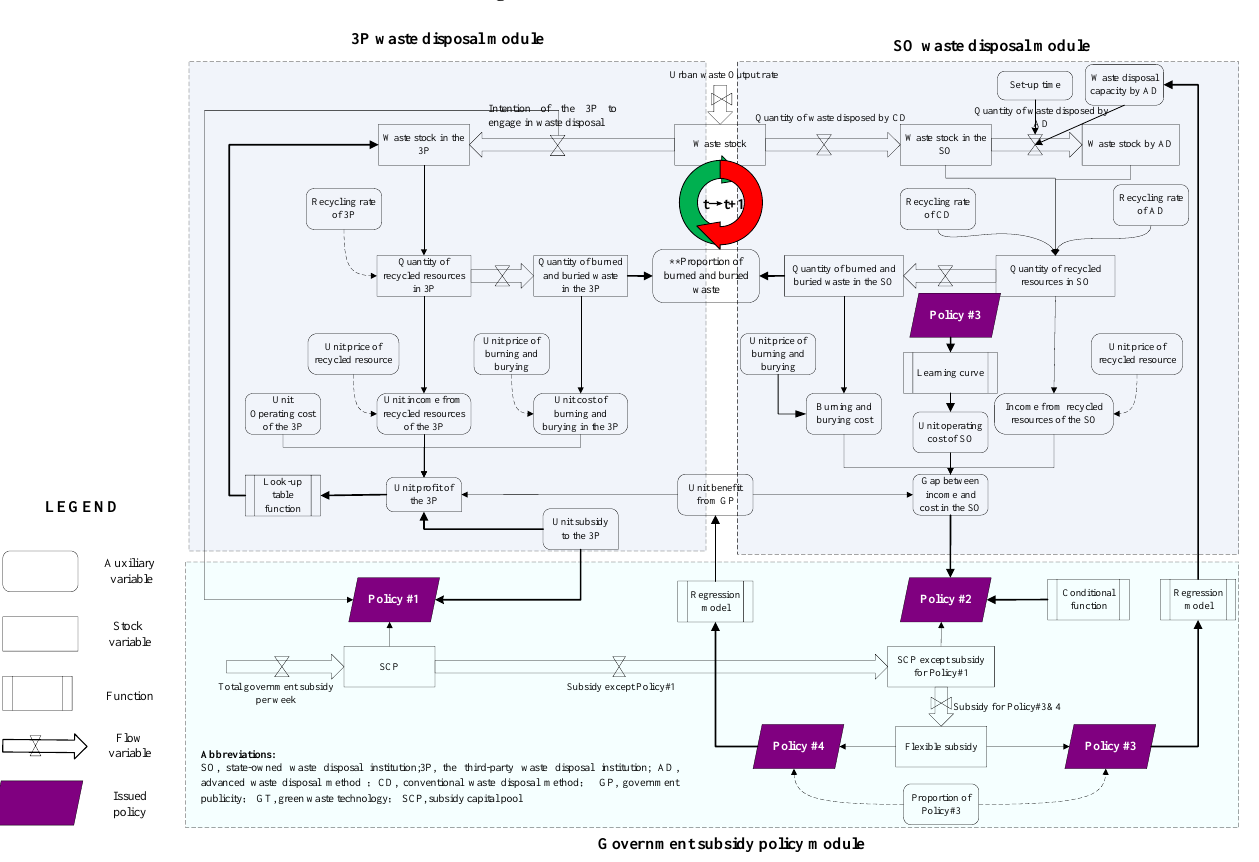
Figure 5. SD model of UWRS.